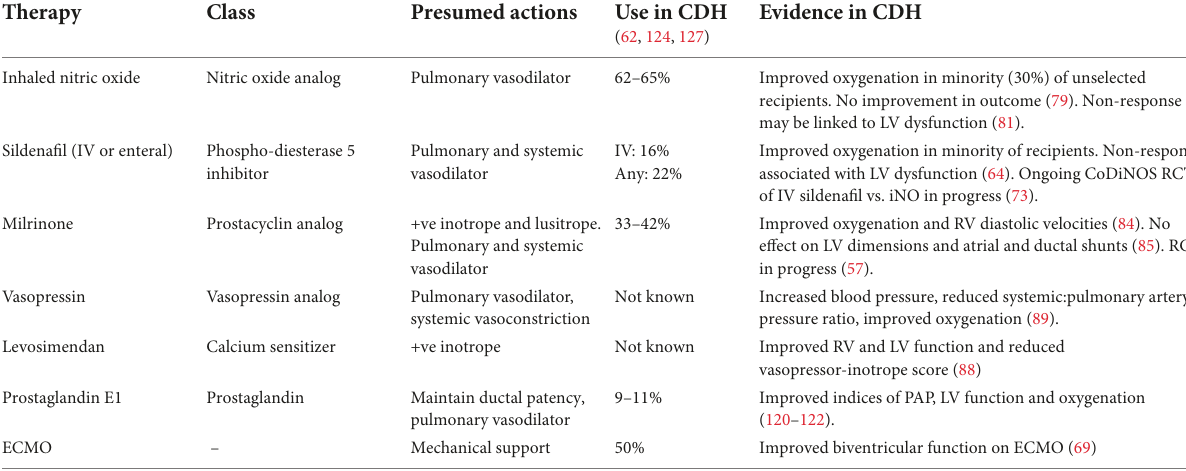
TABLE 5 Hemodynamic therapies investigated in